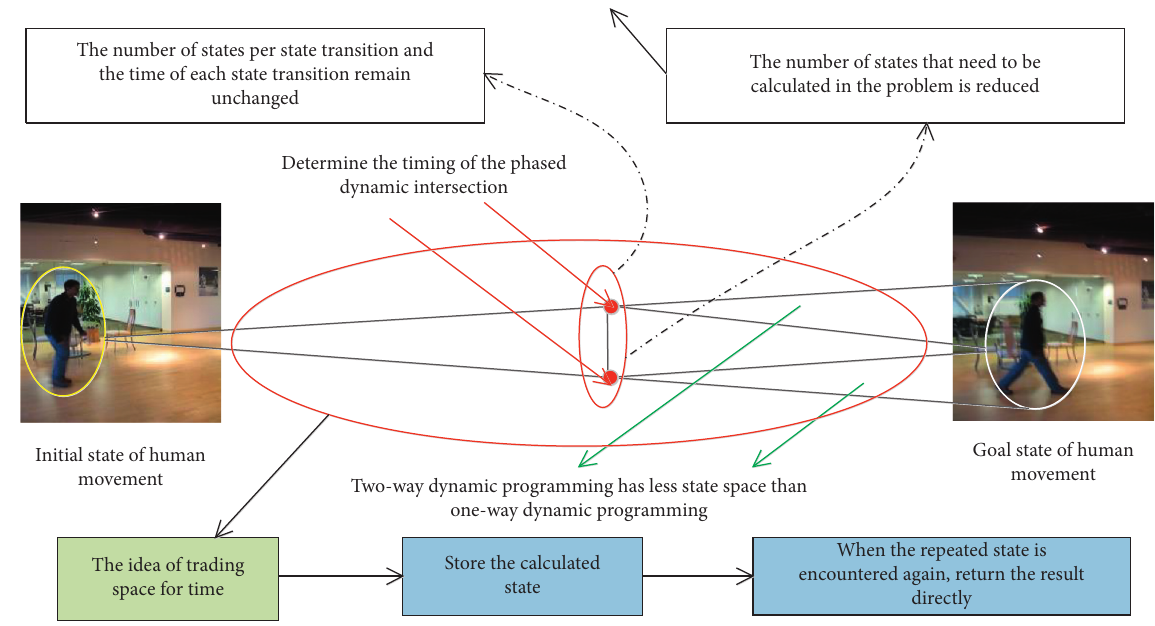
Figure 3: State space diagram of two-way and one-way